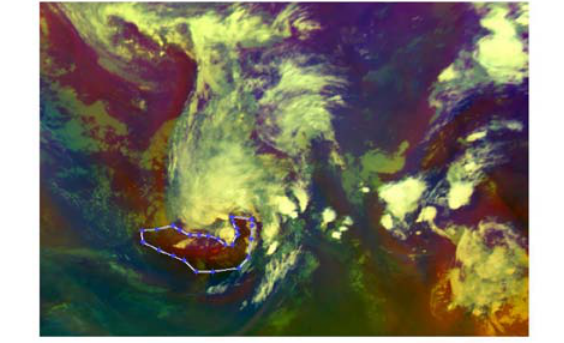
Figure 1. RGB composite image dated 5. August 2010 18:00 UTC. An example of subjective marking off (white line) a dry